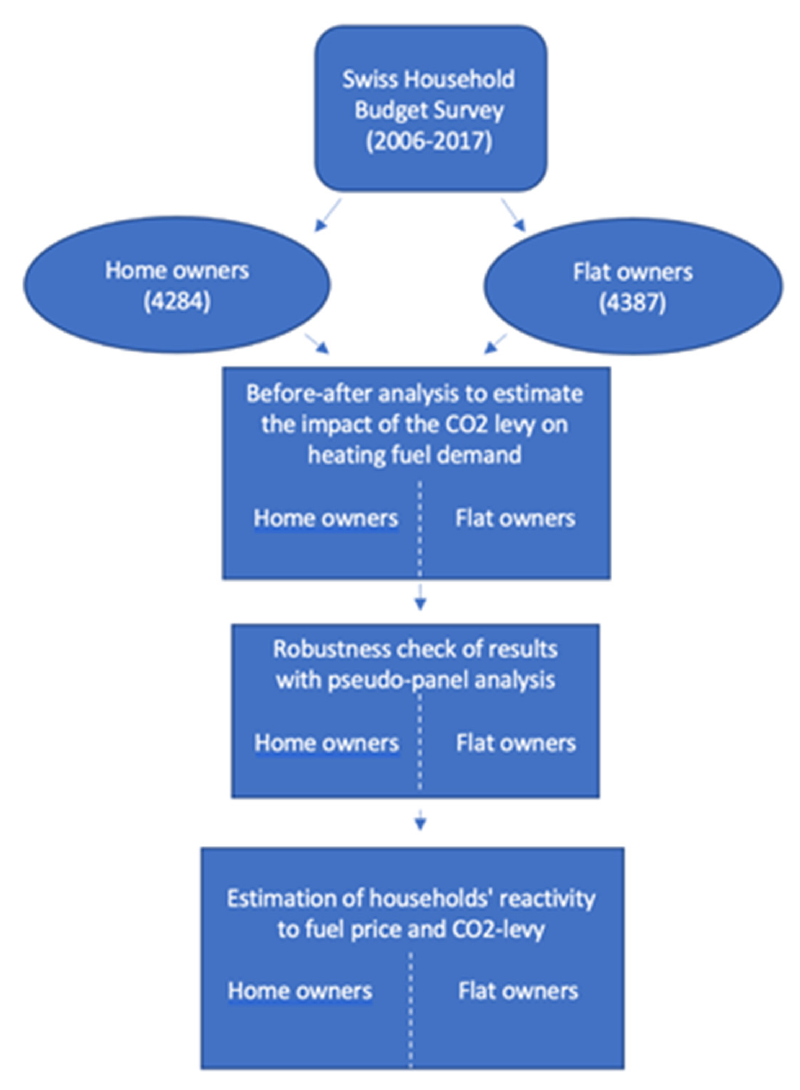
Figure 1. Different steps of the methodology.